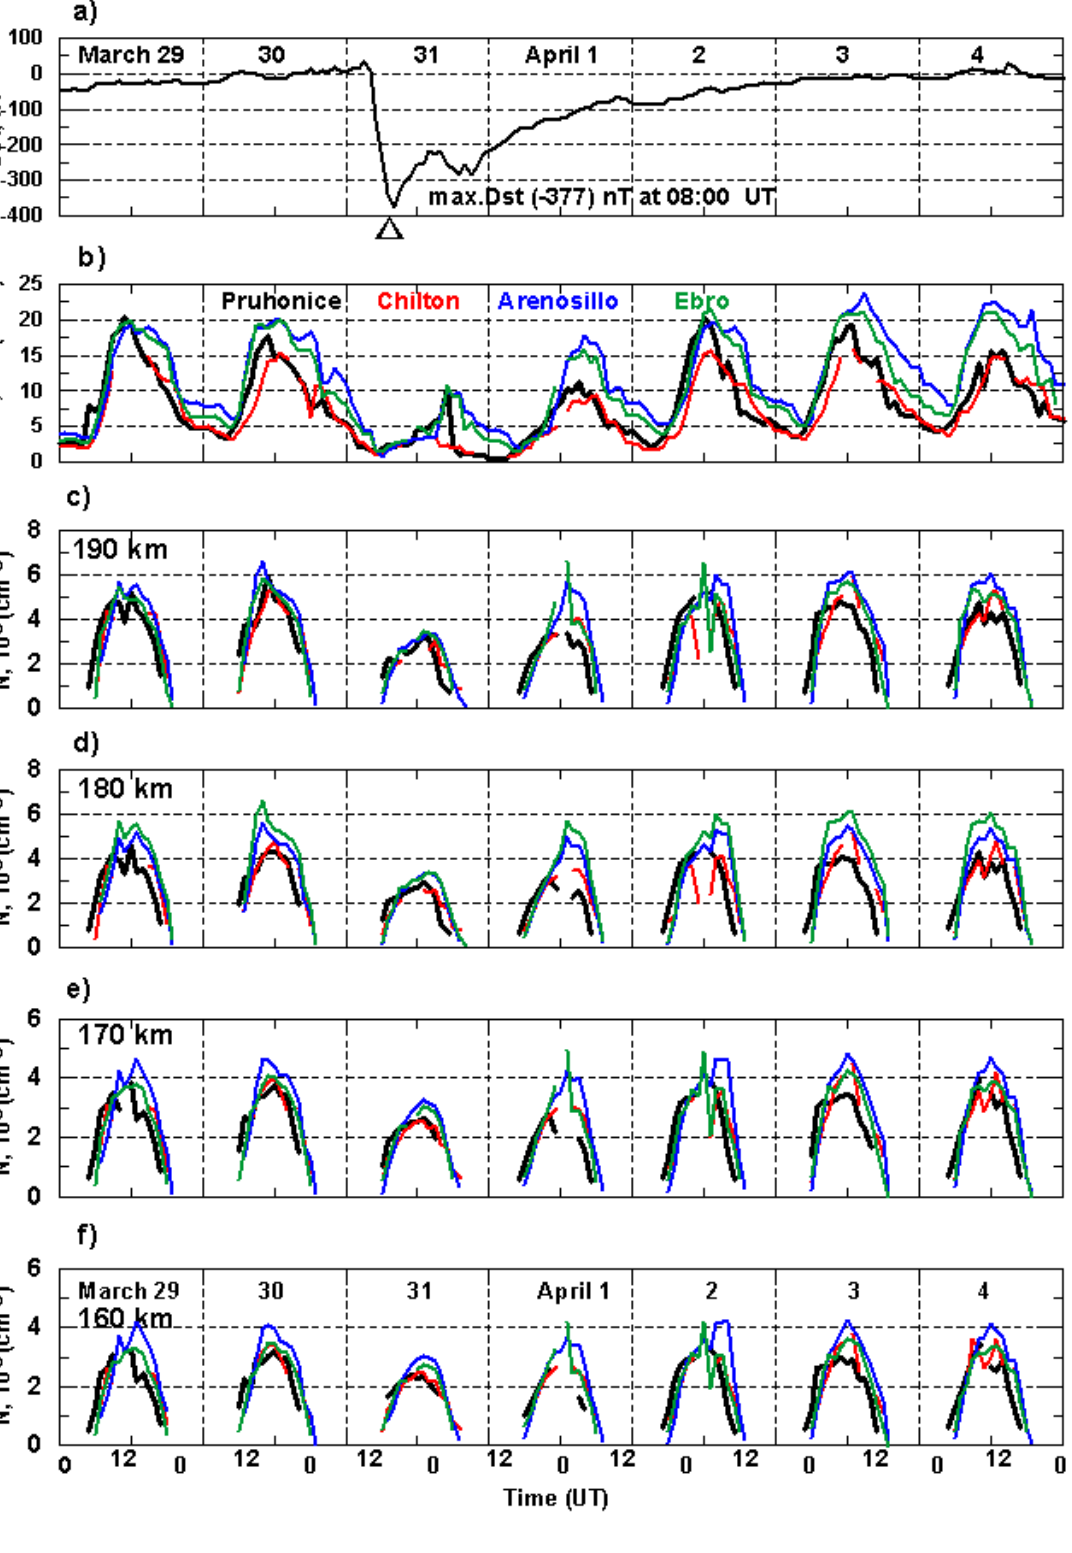
Fig. 8. Results for the March–April 2001 super storm: (a) hourly D st indices, (b) hourly values of Nm F2 for Chilton, Pruhonice, Ebro and Arenosillo, (c–f) daytime electron density at 190, 180, 170 and 160km, respectively, for all stations. Time is in